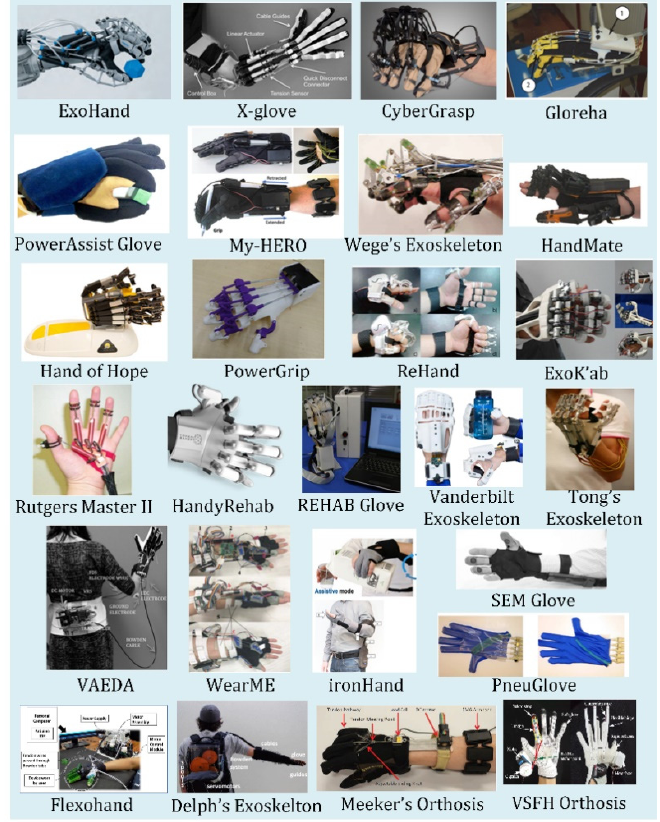
Figure 5. Exoskeleton Devices reviewed in this paper.